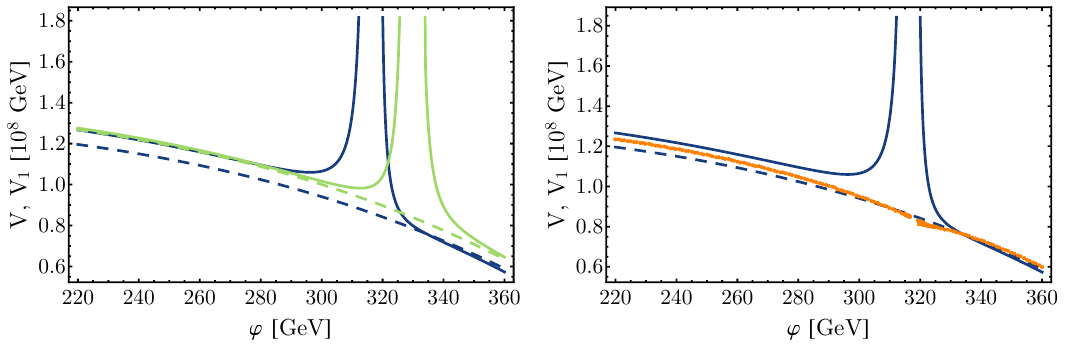
Figure 3 . Contour plots of t (0) (cid:3) ( (cid:22); h; ’ ) for h = 246 GeV in di(cid:11)erent ranges of ’ . In the left panel also the hypersurfaces B = 0 (red solid line) and V (1) = 0 (black dashed line) are displayed.